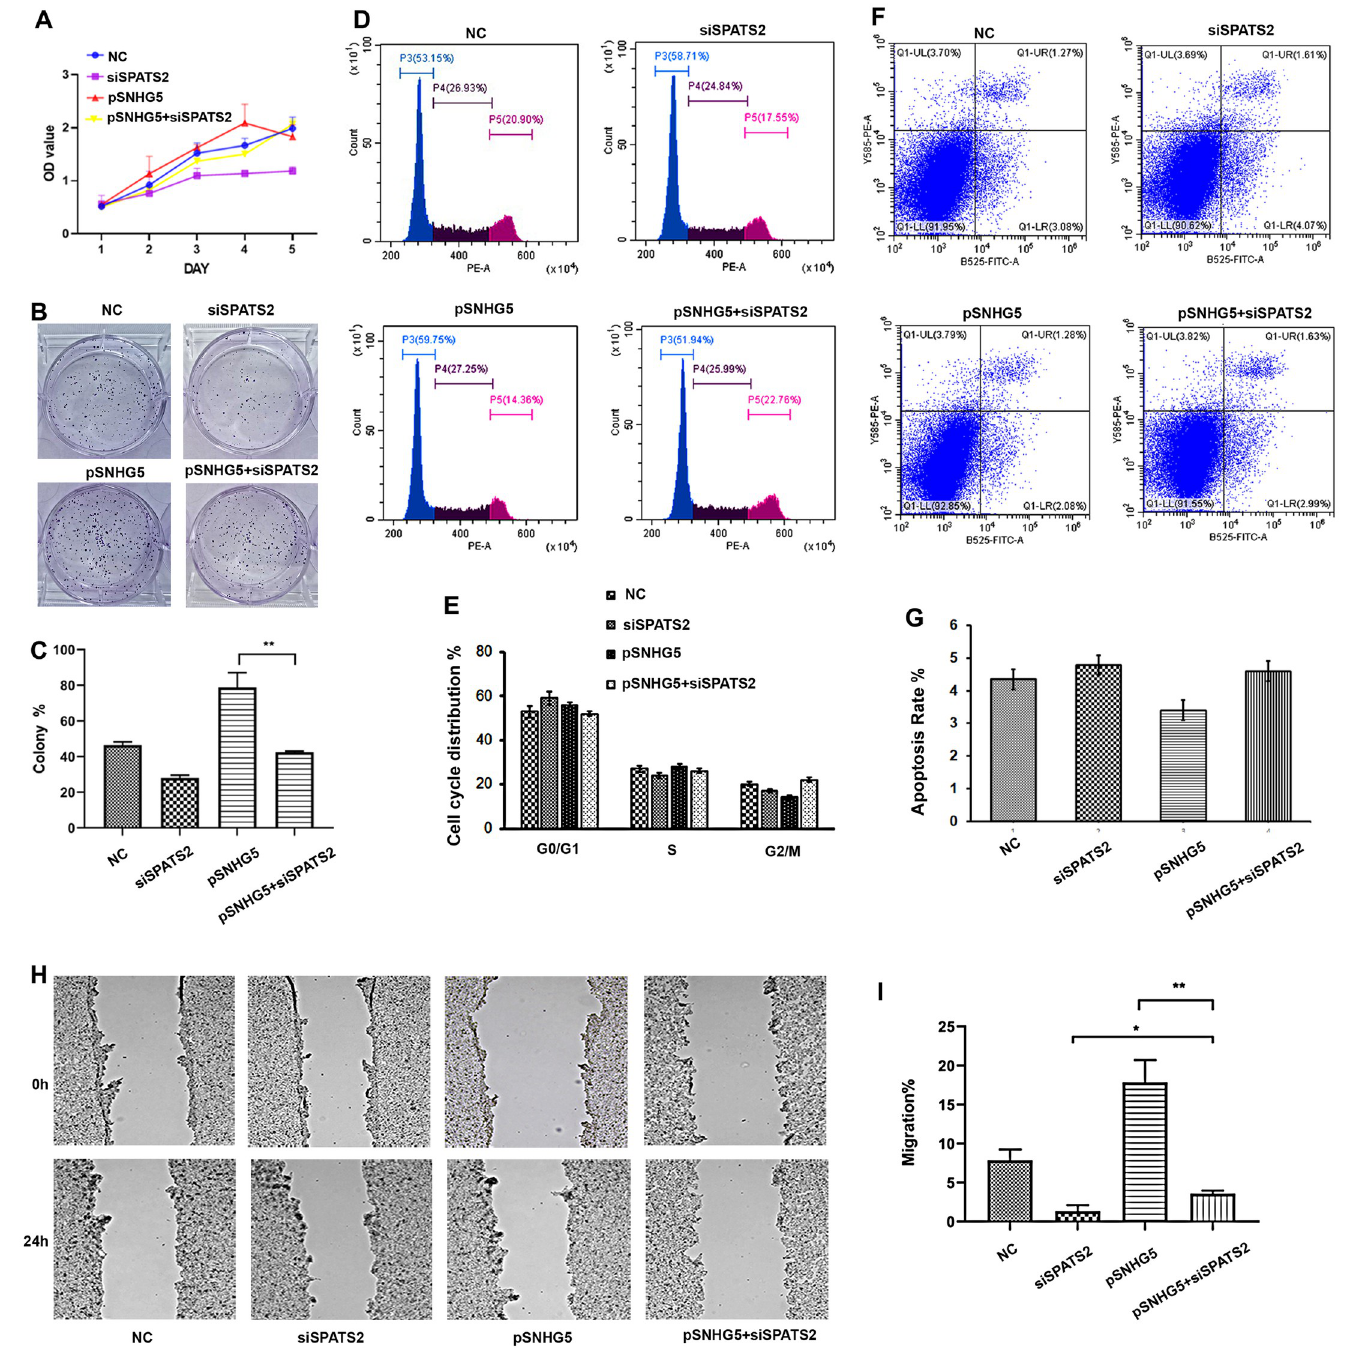
Fig 4. Overexpression of SNHG5 promotes proliferation and migration in the SPATS2 knockdown HepG2 cell line. (A-C) Overexpression of SNHG5 promoted cell proliferation (A) increased the clonogenic survival ability (B, C), abnormal cell cycle (D-E), repressed cell apoptosis (F, G) in SPATS2 knockdown HepG2 cells. (H, I) Wound healing assays after SNHG5 was overexpressed in SPATS2 knockdown HepG2 cells. � P < 0.05, �� P < 0.01, �� P < 0.001.